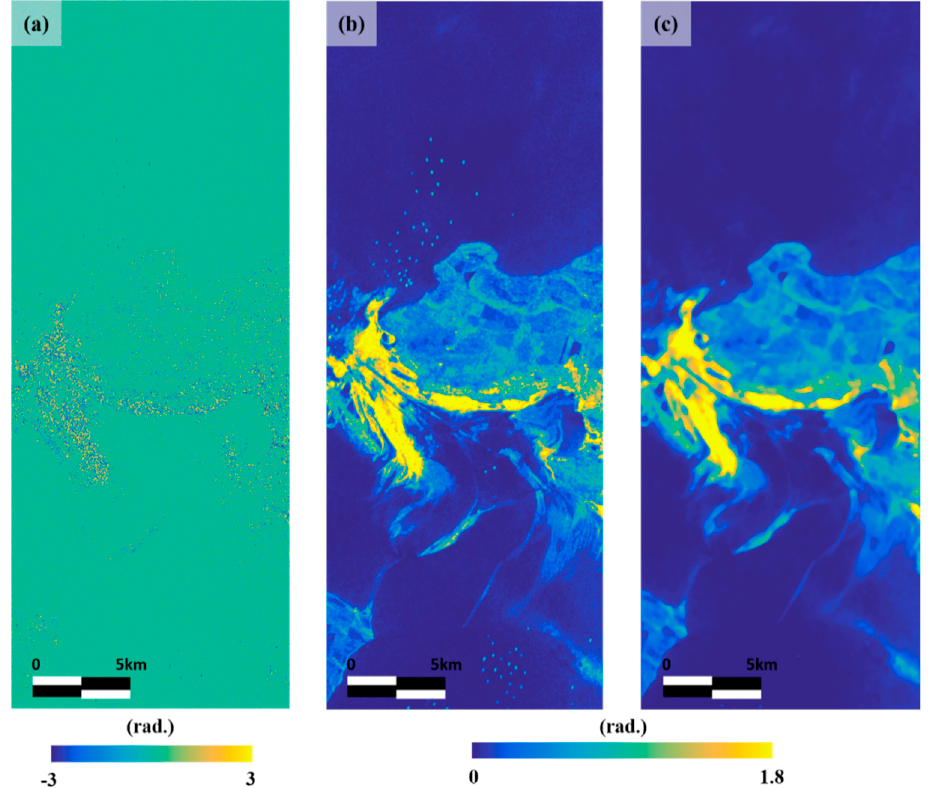
Figure 7. Generation of phase texture map: ( a ) CPD image; ( b ) phase texture map before ship removal, and ( c ) hase texture map after ship removal.